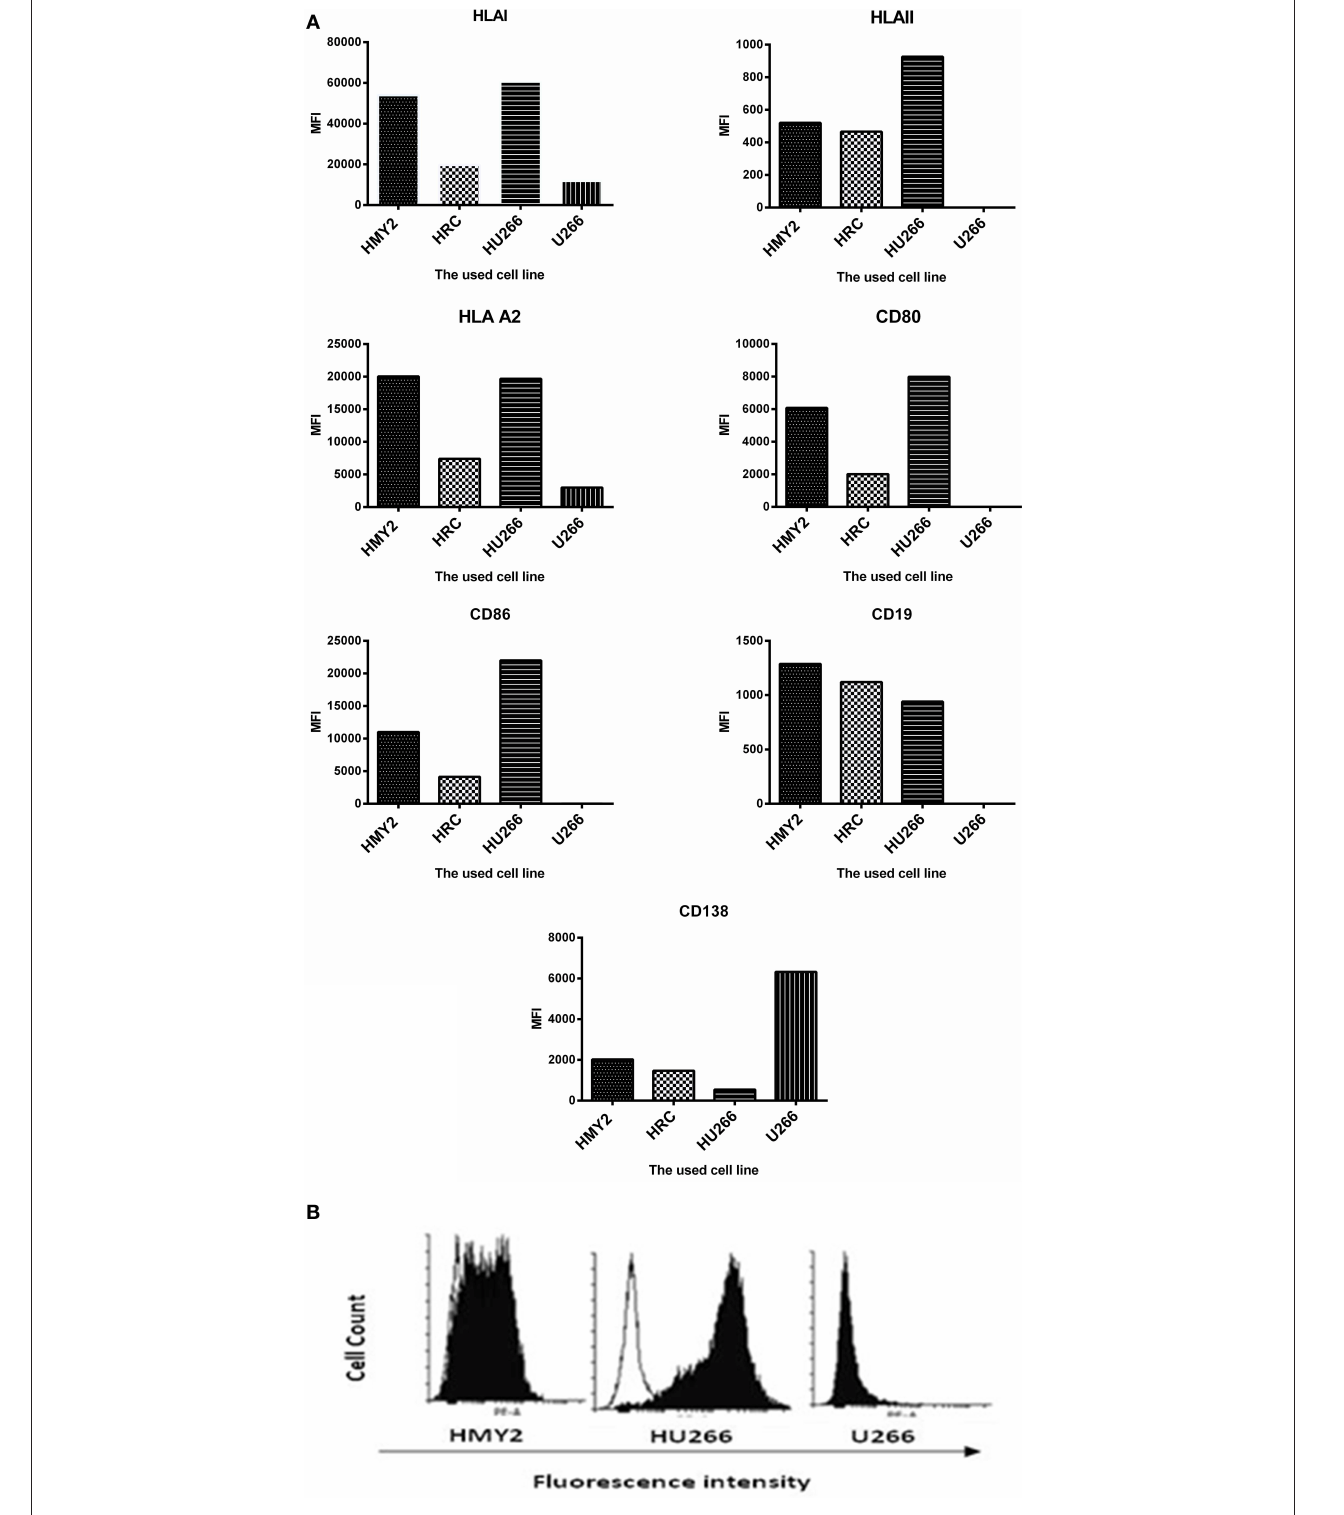
FIGURE 1 | Phenotypic characterization of HMY2, the hybrid cell lines, and U266. (A) Mean fluorescence intensity (MFI) of FACS analysis for determination of the expression of HLA class I, HLA-A2, HLA class II, CD80, CD86, CD19, and CD138. (B) A representative example of flow cytometry histograms showing expression of co-stimulatory marker CD86 on HU266, the APC cell line HMY2 and the myeloma cell U266. The analyses were conducted at least twice.